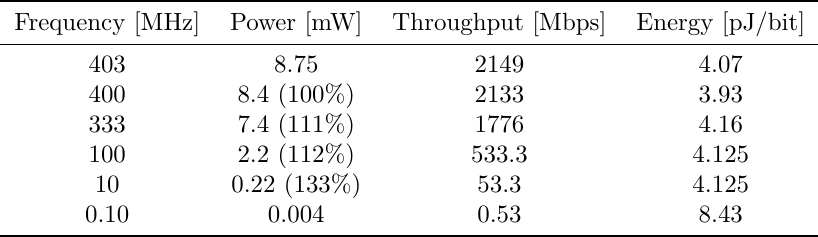
Table 20: Impact of clock frequency on the ASIC results with N u = 8. The percentages are the comparison with the Spook v1 corresponding metrics.